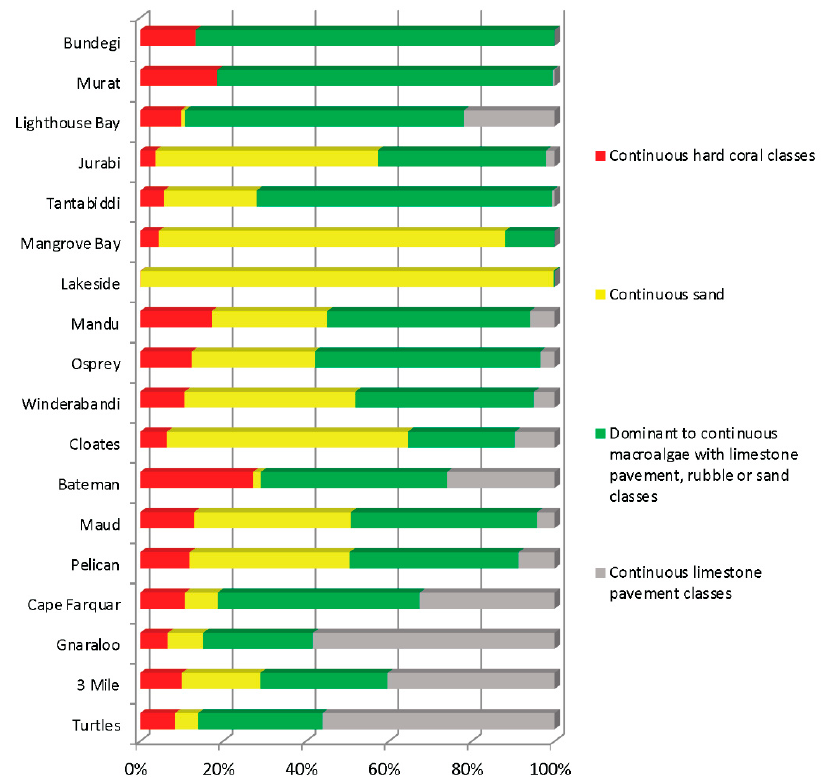
Figure 4. Overview of the main benthic classes for all mapped sanctuary zones. Data are arranged north to south along the Ningaloo Reef coast, and the locations are indicated in Figure 1. Some of these zones extend into deeper waters, thus beyond this study’s 20 m depth range.